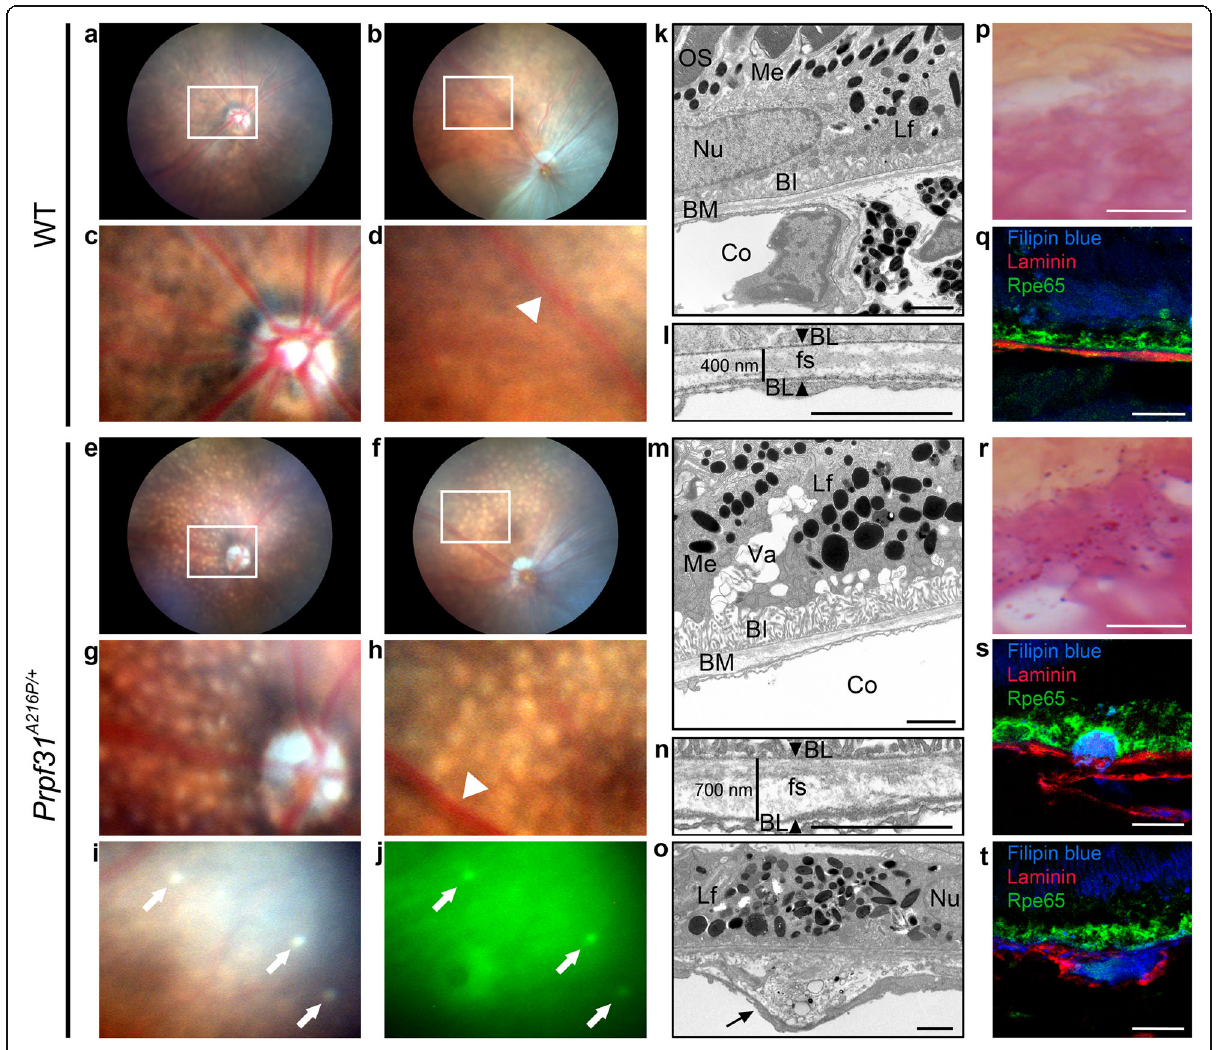
Fig. 1 Prpf31 A216P/+ mice exhibit degenerative phenotype of the RPE with drusen-like deposits. Funduscopy of WT ( a - d ) and Prpf31 A216P/+ mice ( e - j ) are shown. Numerous white-yellowish round lesions were observed in the retina of Prpf31 A216P/+ mice ( e - h ). These lesions were distributed in the central ( g ) and peripheral retina ( h ) and most of them showed autofluorescence ( i , j ; white arrows). The optic nerve head ( g ) and retinal vessels ( h ; white arrowhead) did not show differences when compared to WT mice ( c , d ; white arrowhead). TEM images of RPE of 8-month-old WT ( k, l ) and Prpf31 A216P/+ mice ( m - o ) and the amplified images of Bruch ’ s membrane (BM) are displayed ( l, n, o ). Photoreceptor outer segments (OS) were observed in contact with the RPE microvilli in WT mice ( k ). Accumulation of lipofuscin granules (Lf), large vacuoles (Va) and atrophy of basal infoldings (BI) were observed in the RPE of Prpf31 A216P/+ mice ( m ). The distance between both basal laminae (BL) was measured ( l, n ; arrowheads), and thickening of the BM was detected in Prpf31 A216P/+ mice ( n ). In addition, the homogeneity of the fundamental substance (fs) was lost and amorphous electrodense material was accumulated within the BM of these mice ( o ; black arrow). The morphology of melanin granules (Me), nuclei (Nu) and choroid (Co) was normal. Lipofuscin staining in dark magenta ( p, r ) showed large accumulation of lipofuscin granules in the RPE of Prpf31 A216P/+ mice ( r ). Filipin blue dye was used to stain free cholesterol ( q, s, t ; blue). Prpf31 A216P/+ mice showed free cholesterol accumulation ( s, t ; blue) between the RPE and BM ( s ) or within the BM ( t ). Anti-Laminin antibodies were used to stain the BL ( q, s, t ; red) and the RPE was visualized by anti-Rpe65 antibody ( q,s, t ; green). Scale bars represent 2 μ m ( k-o ) or 12.5 μ m ( p - t the neuroretina (Fig. 2d). Antibodies against Rhodopsin without primary antibody, was performed to discard and Rpe65, an enzyme of the visual cycle cascade non-specific binding of secondary antibody (Fig. 2c). expressed in the RPE, were used as fraction-specific To compare differential expression of Prpf31 protein in markers (Fig. 2d). This result was further confirmed by different layers of the mouse retina, neuroretina and RPE qPCR (Fig. 2e), in which it is possible to observe that were manually dissected and protein and mRNA samples Prpf31 expression level is much higher in the RPE, when were obtained from each fraction. Immunoblotting results indicate high expression of Prpf31 protein compared to